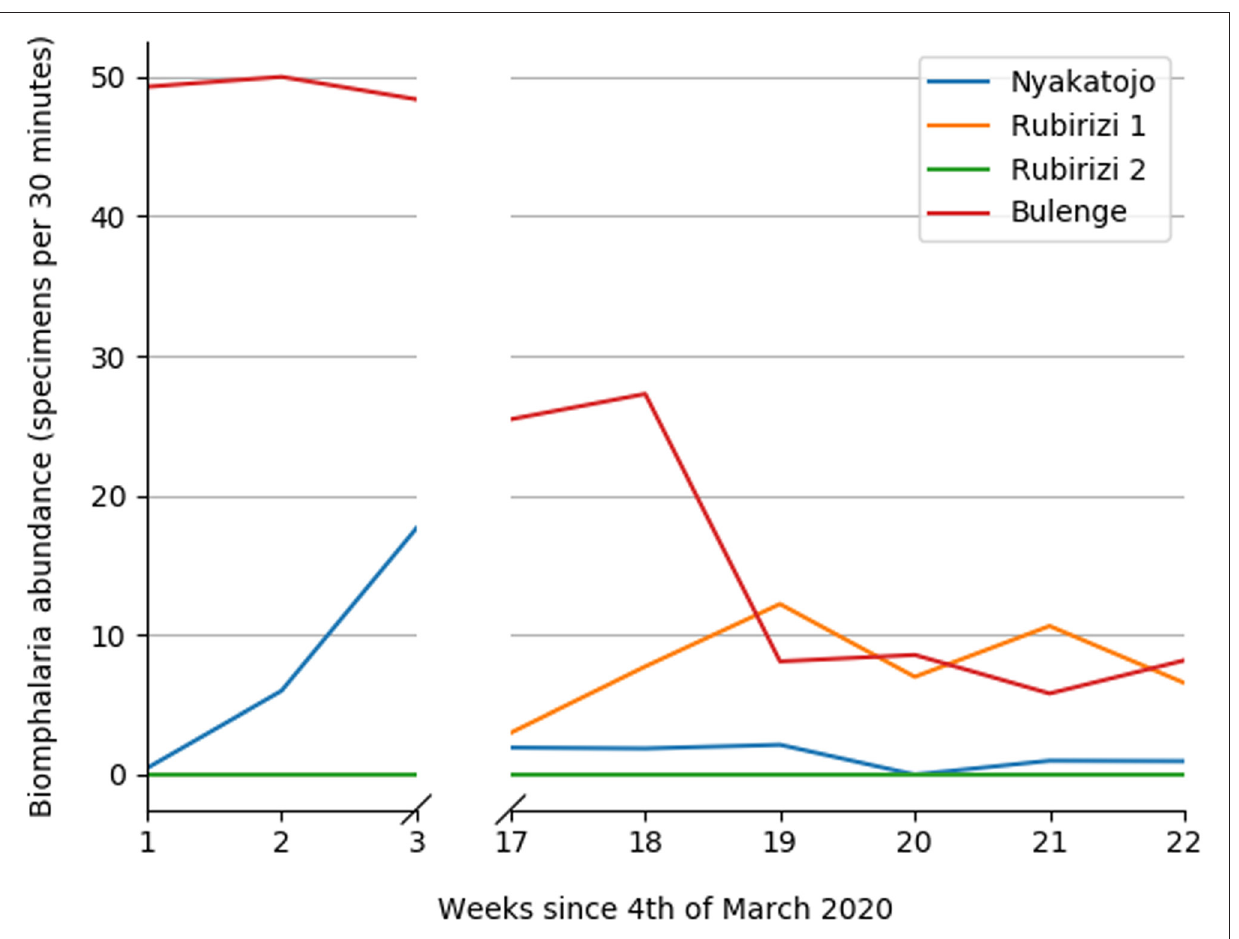
Figure 5 Sampled Biomphalaria sp. abundances through time at four sites monitored by a single citizen scientist (ID